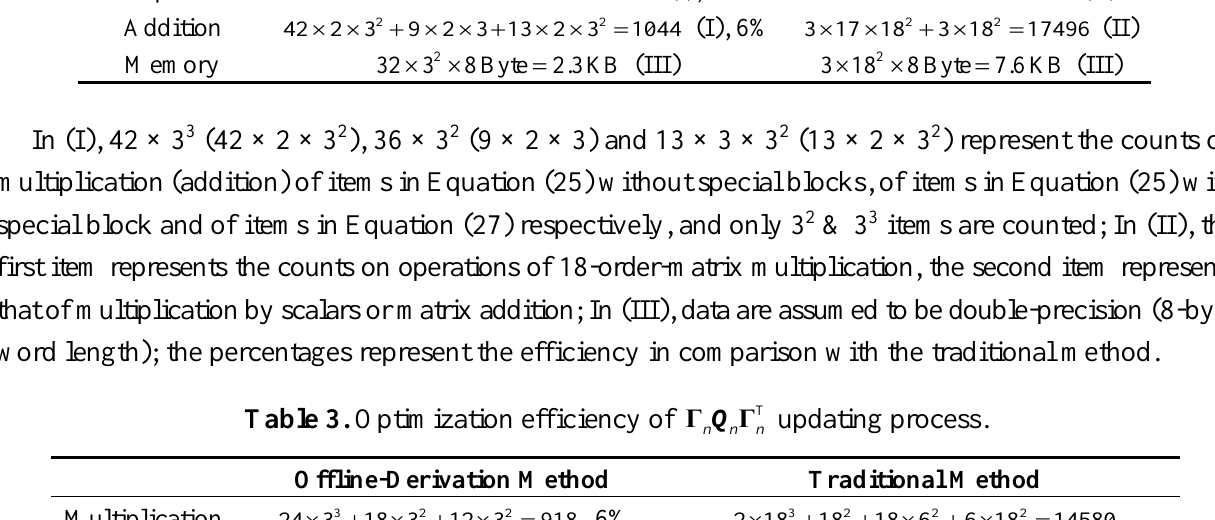
Table 2. Optimization efficiency of